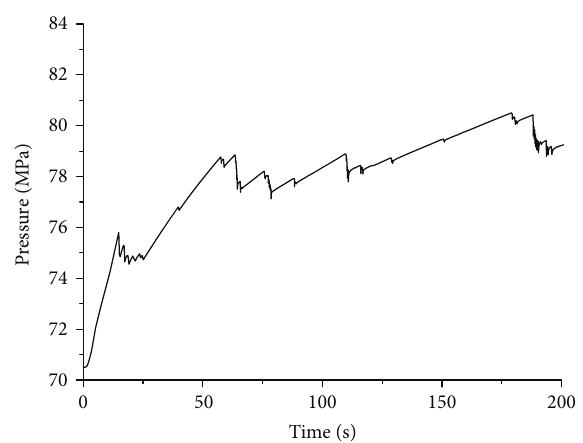
Figure 22: Pressure curve at the NF approaching angle of 45 ° and stress anisotropy coe ffi cient of